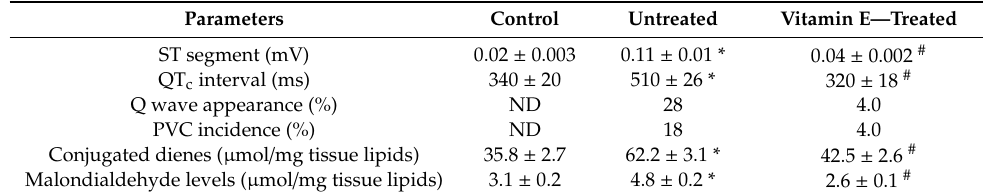
Table 4. Electrocardiographic and oxidative stress parameters in rat hearts 21 days after coronary artery occlusion with or without vitamin E (25 mg / kg / day)